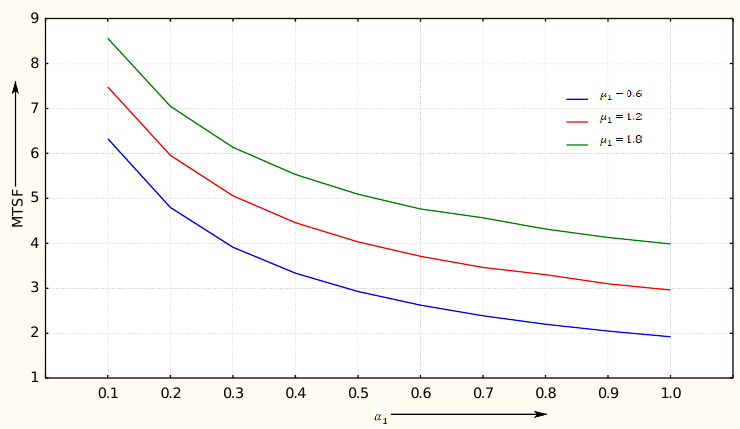
Figure 2. Behaviour of MTSF w.r.t 𝛼